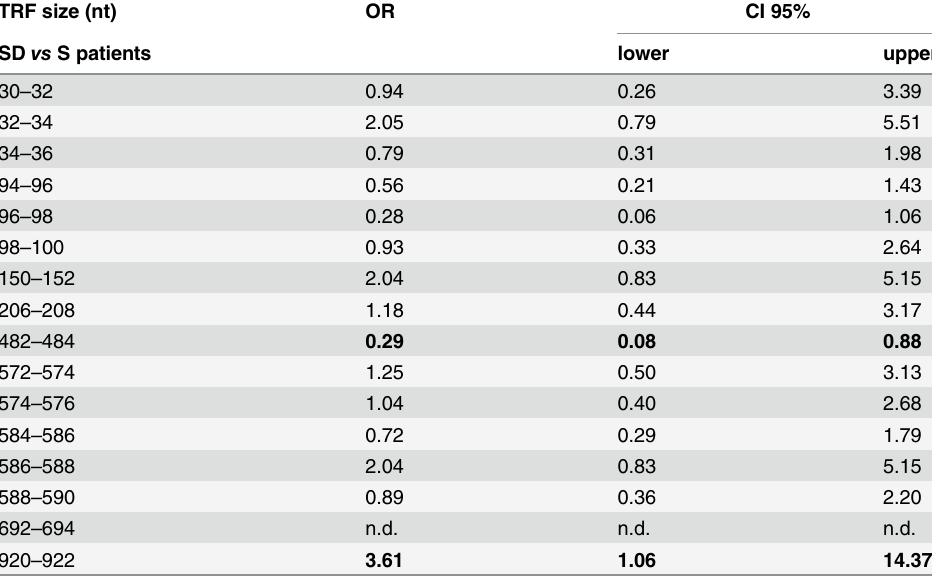
Data report the T-RFs size in nucleotides (nt), the CMLE odds Ratio (OR) estimates of association between presence of the T-RF and SD status, and the 95% con fi dence intervals (CI 95%). The reported attributions indicate the main hits retrieved for that particular size. Statistically signi fi cant ORs are reported in